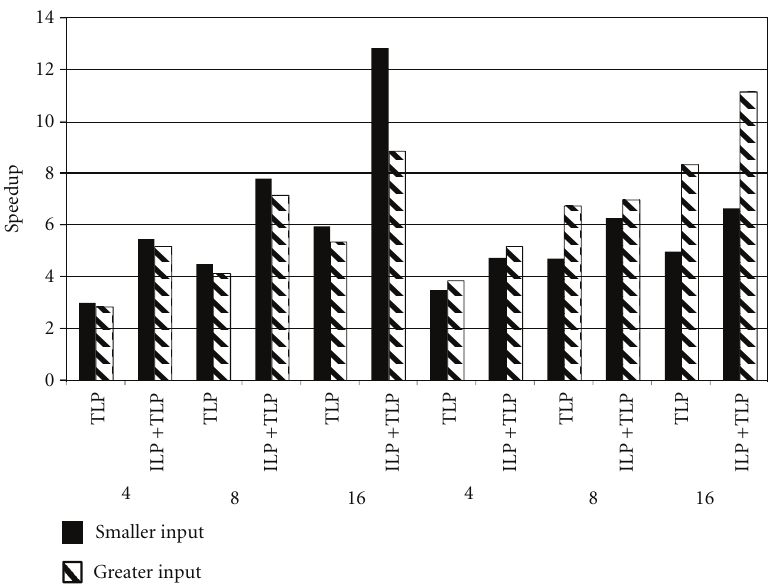
Figure 7: FFT and LU performance regarding di ff erent application data set